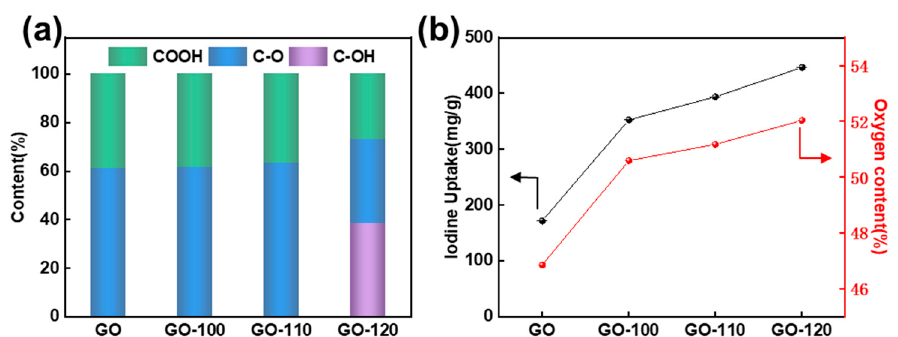
Figure 4. ( a ) contents of different oxygen-containing groups and ( b ) iodine uptake performance of GO, GO-100, GO-110 and GO-120.